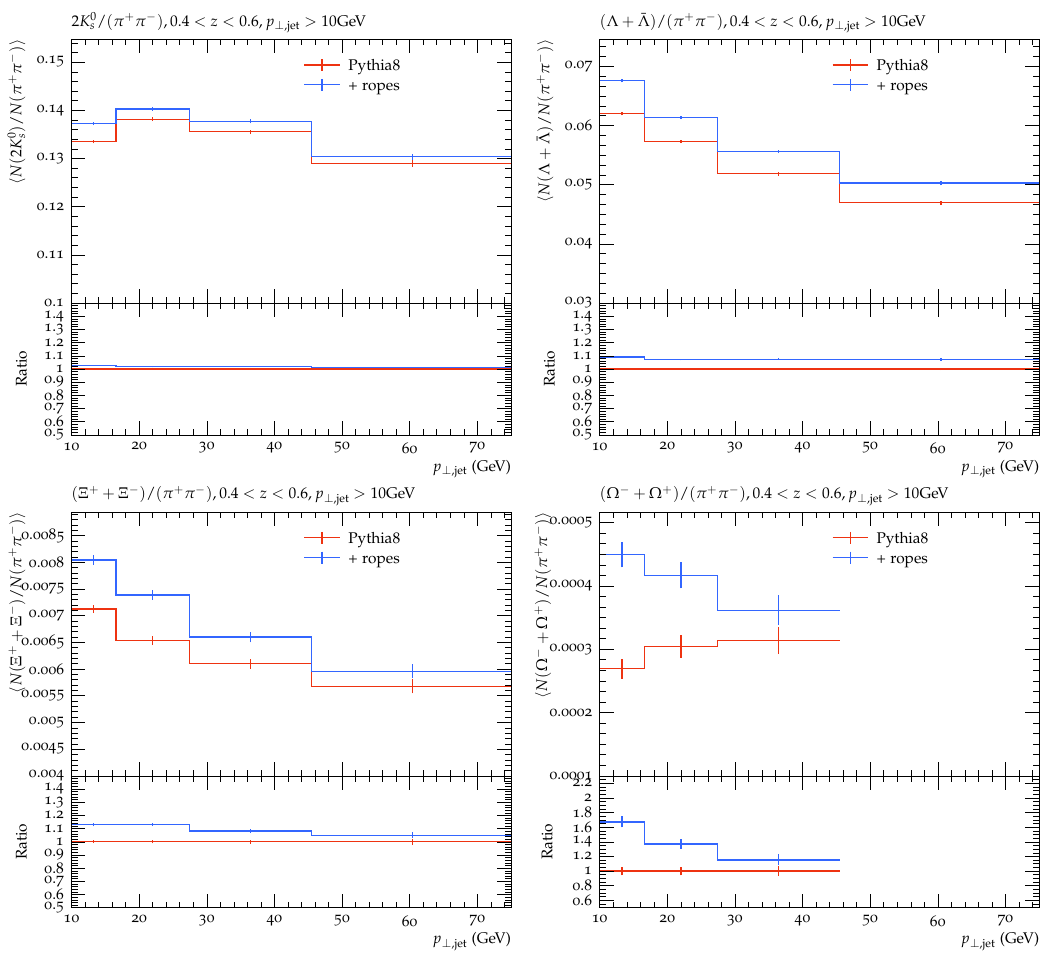
Figure 8: Yield ratios of particles with 0.4 < z < 0.6, as a function of p ⊥ (cid:112) / ( π + π − ) (top left), ( Λ + ¯ Λ ) / ( π + π − ) (top right), s = 13 TeV: 2 K 0 pp collisions at s ( Ξ − + Ξ + ) / ( π + π − ) (bottom left) and ( Ω − + Ω + ) / ( π + π − ) (bottom